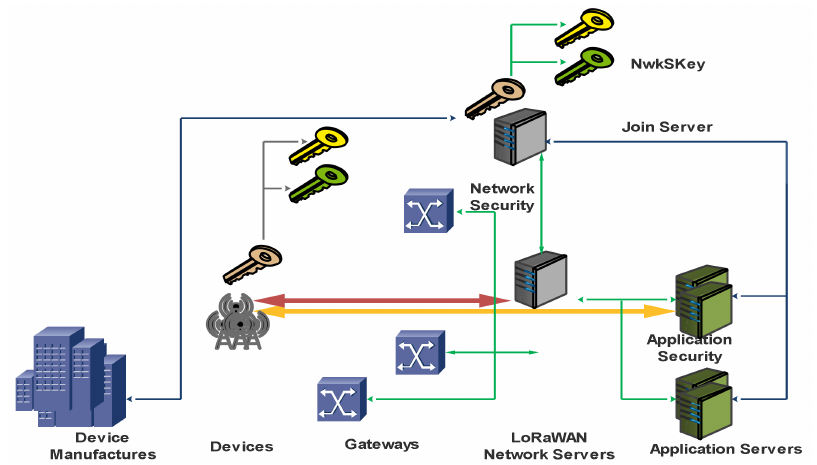
Figure 4. LoRaWAN communication model